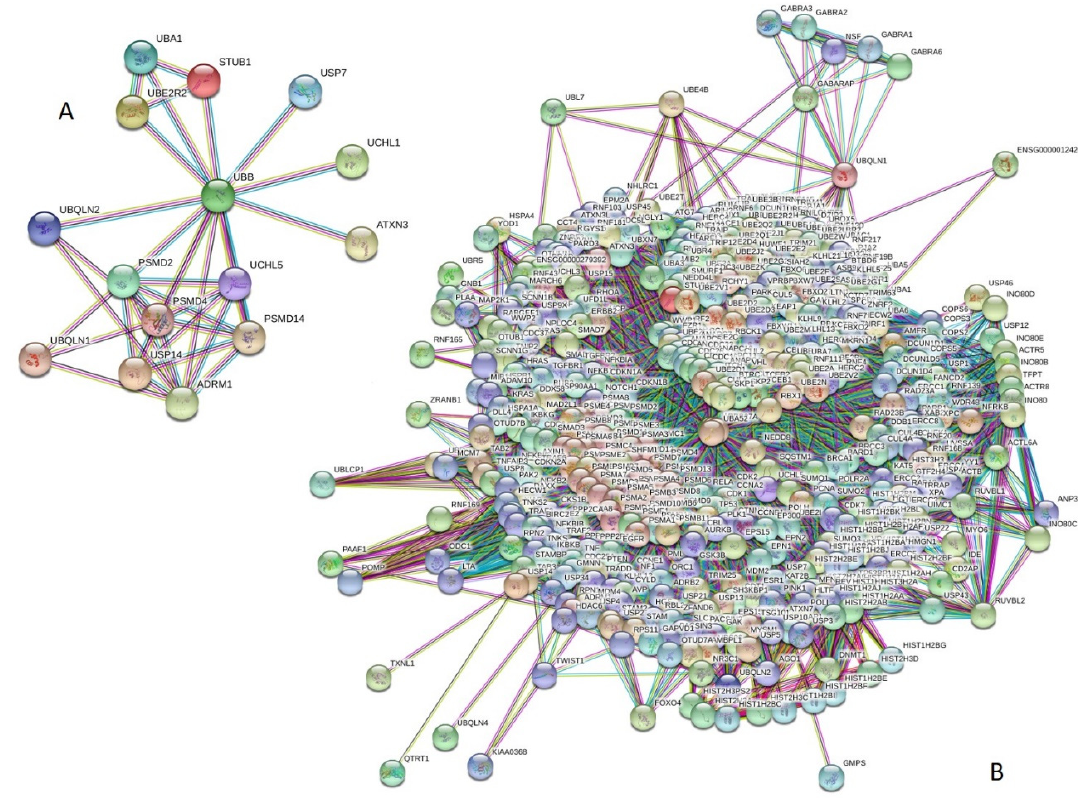
Figure 3. Evaluation of the intractability of 15 UPS proteins associated with human diseases by STRING platform. ( A ) Network of the inter-set PPI interactions (15 subunits, highest confidence level of 0.9). ( B ) PPI network centered at 15 UPS proteins associated with human diseases (515 proteins, highest confidence level of 0.9).